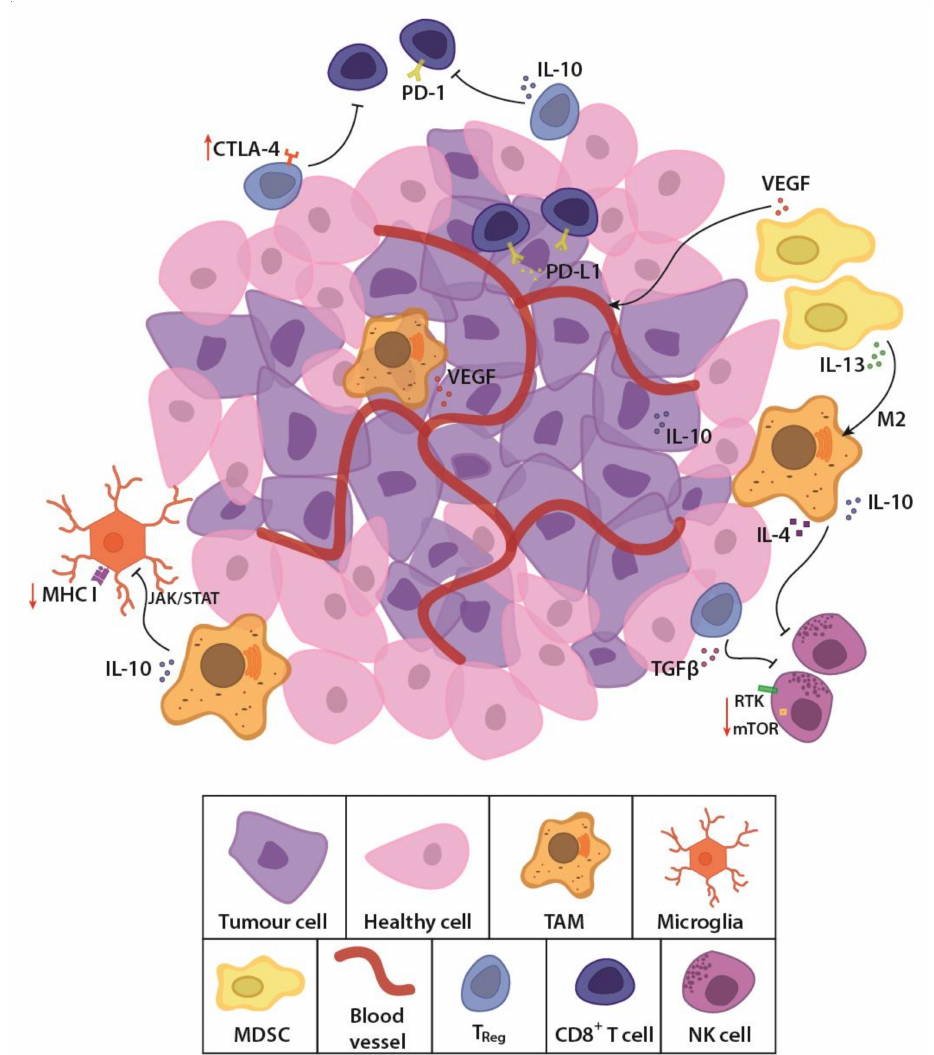
Figure 1. Schematic representation of the glioblastoma (GBM) tumour microenvironment. The evolving tumour microen- vironment consists of diffusely infiltrative tumour cells with a leaky neovasculature, anti-inflammatory stromal